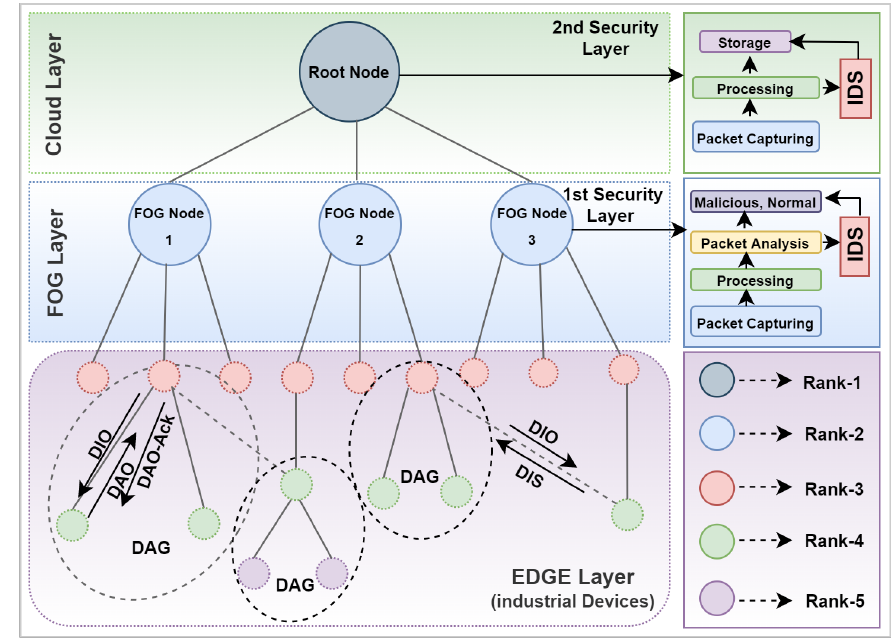
Figure 2. Proposed network